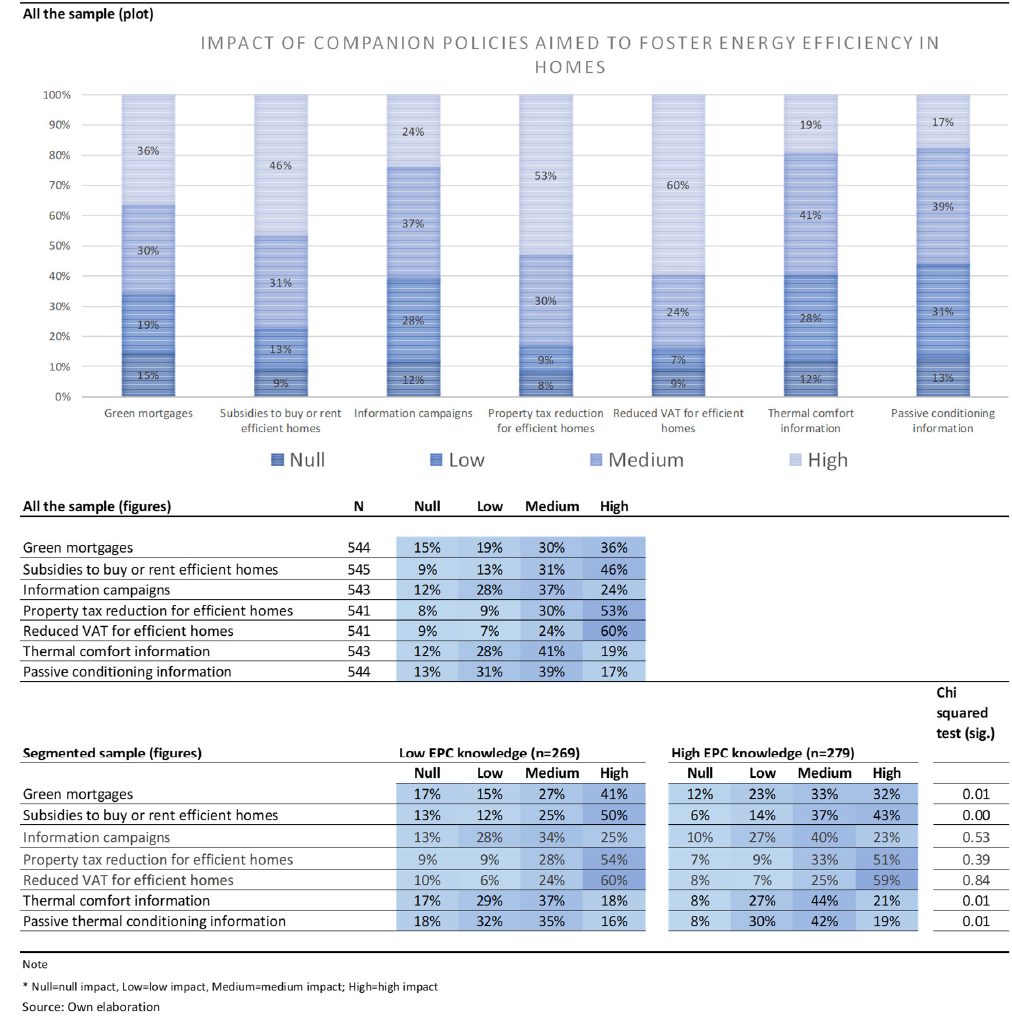
Figure 7. Perceived effectiveness of EPC companion policies aimed to foster efficient homes.